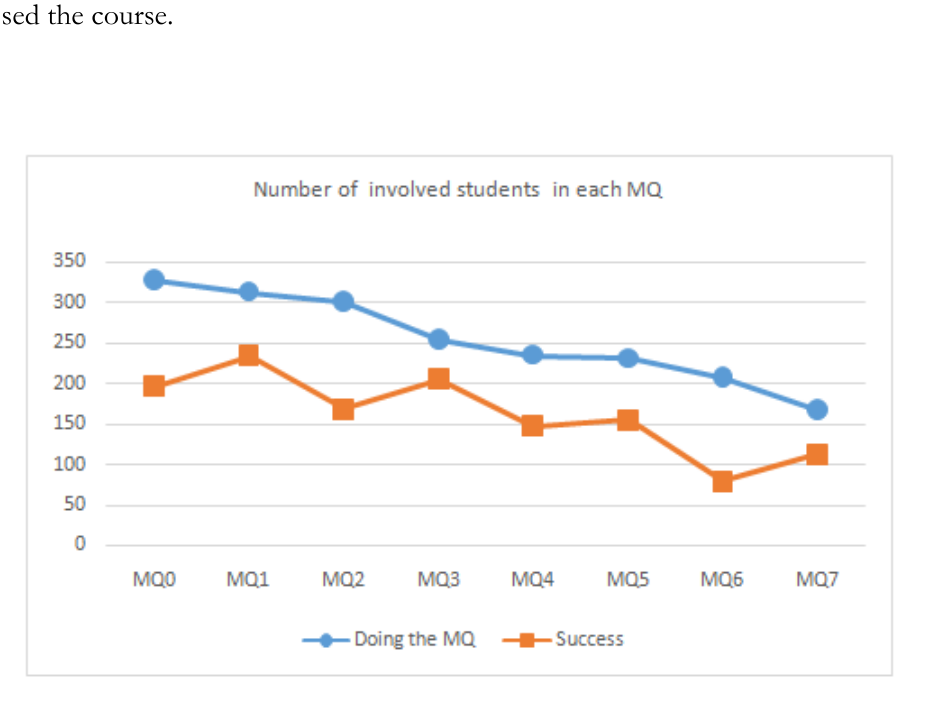
Figure 2. Results of the